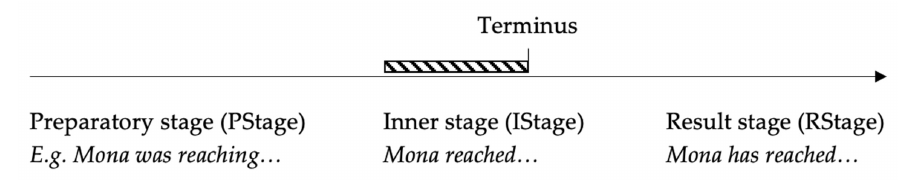
Figure 2. Stage structure for verbal complex ‘Mona REACH the summit’ (Caudal and Roussarie 2000, p.